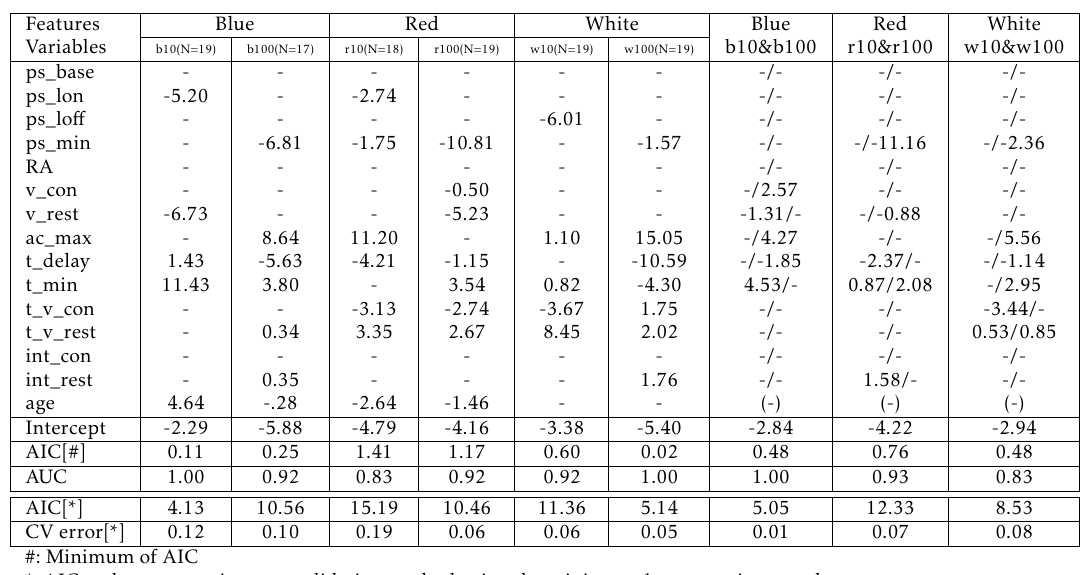
Table 6. Coefficients of β for features of PLR waveforms